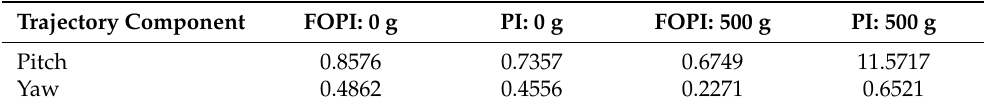
Table 7. RMSE of controllers designed with φ m = 60 ◦ and ω gc = 5 rad/s.